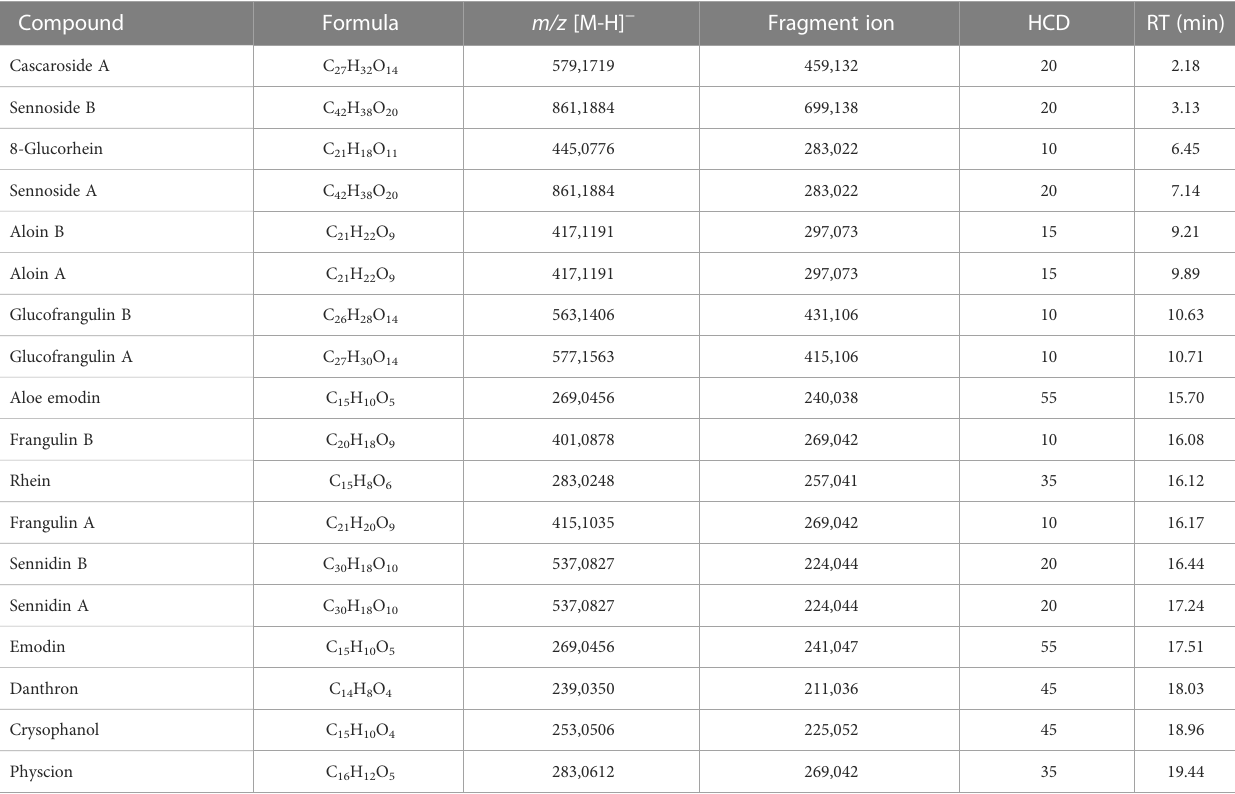
TABLE 2 List of analytes considered for the characterization of the samples listed in Table 1 .